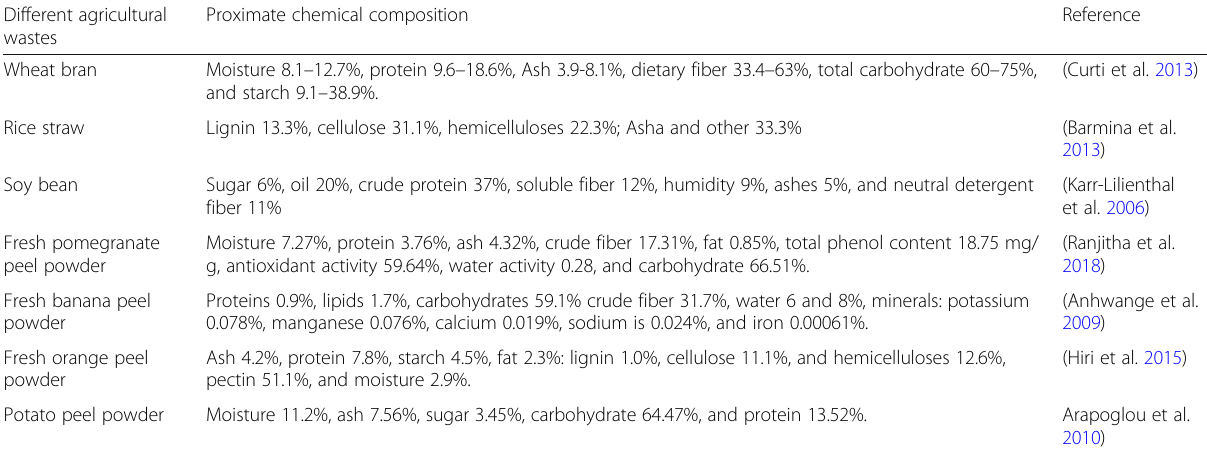
Table 1 The proximate chemical composition for different agricultural wastes used as a substrate Different agricultural